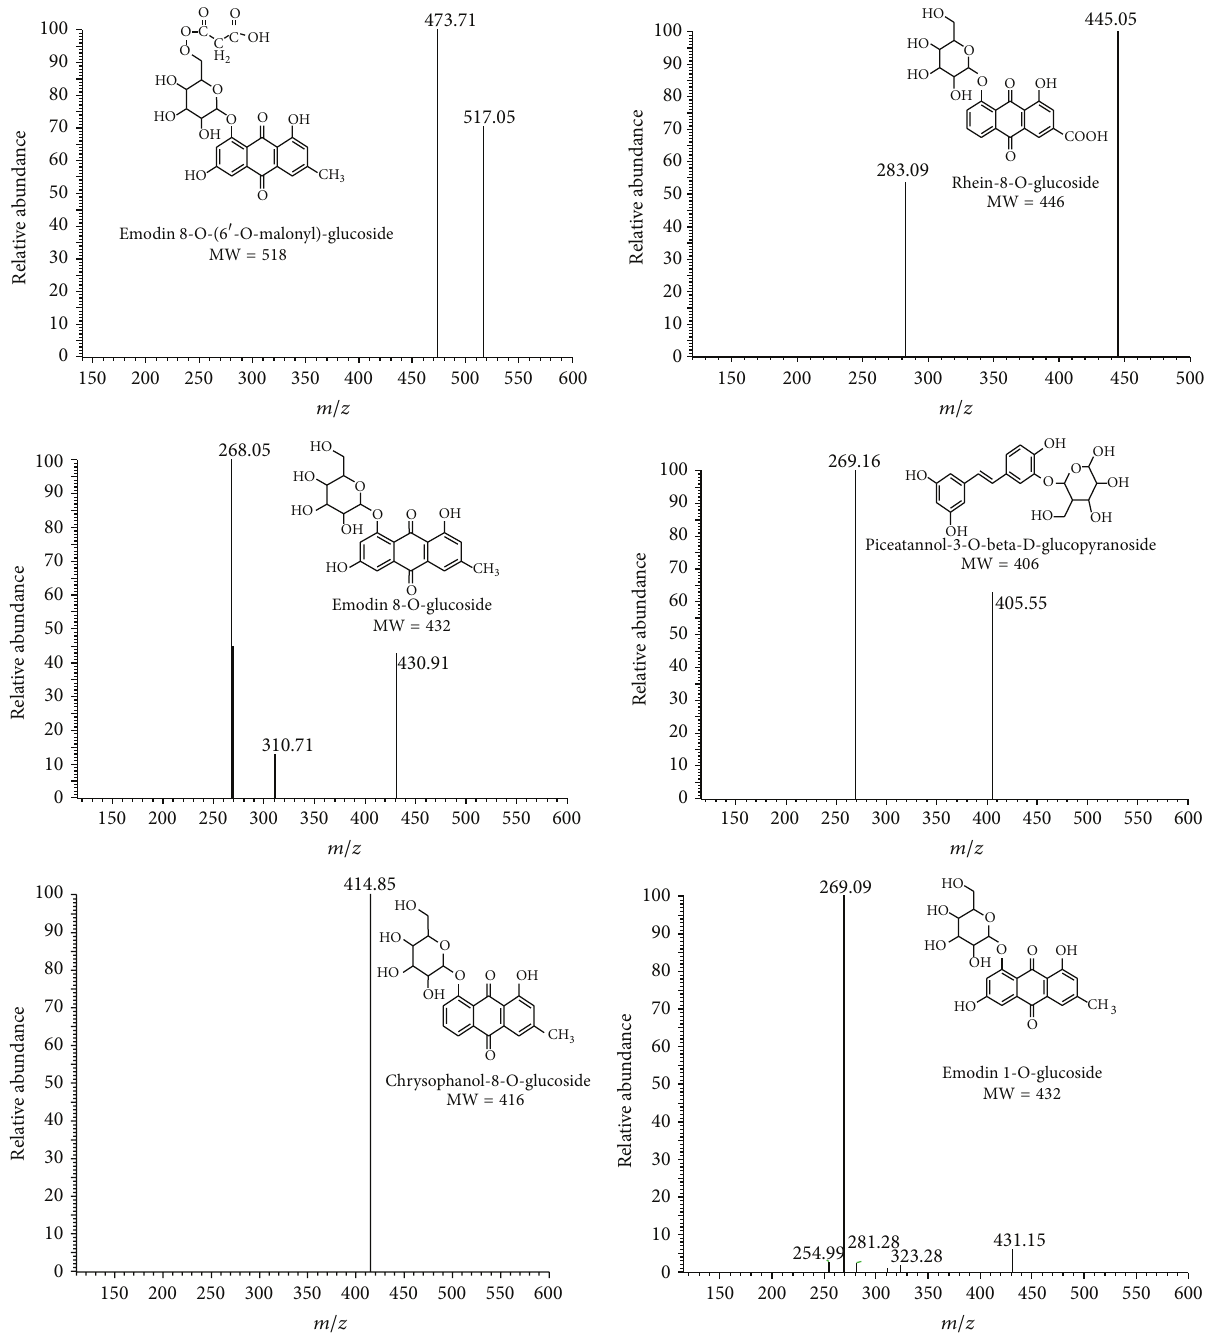
Figure 4: ESI-MS/MS of rhubarb anthraquinone